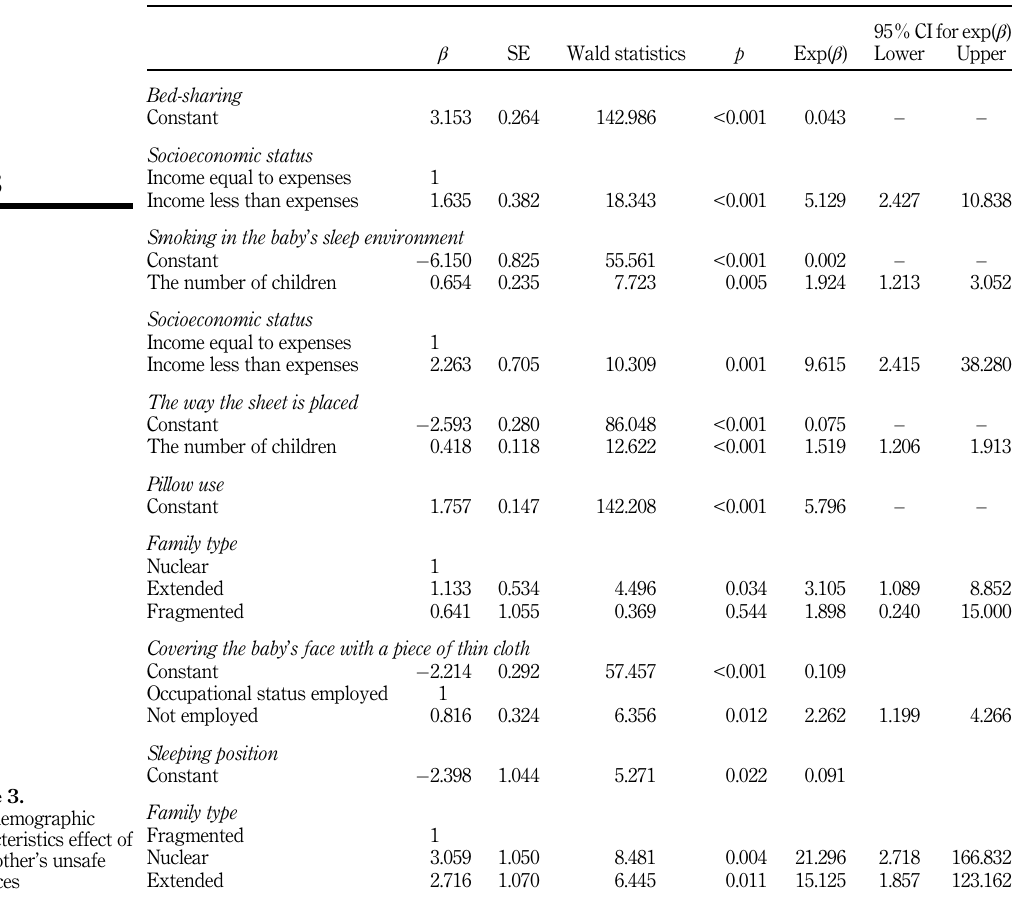
Table 3. Sociodemographic characteristics effect of the mother ’ s unsafe